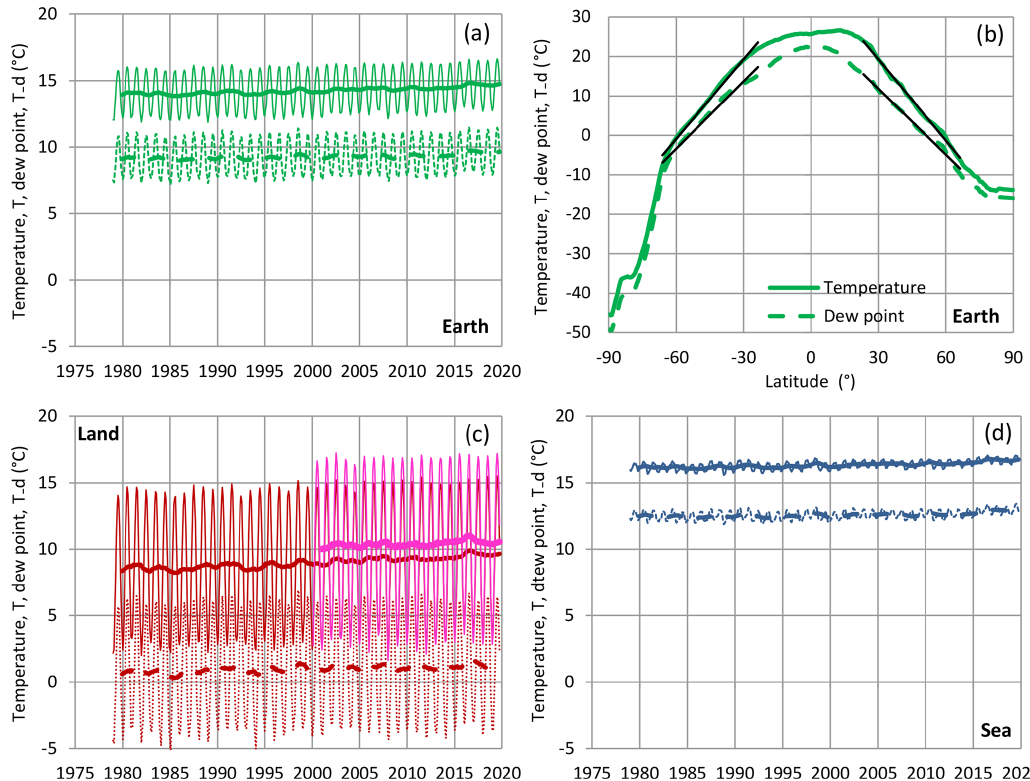
Figure 2. (a) Variation of the globally averaged temperature (continuous lines) and dew point (dashed lines) at the level of 2m above ground. Thin and thick lines of the same colour represent the monthly values and running annual averages (right aligned), respectively. (b) Zonal distribution of Earth temperature and dew point; for the temperate zone ( ± 23 . 5 to ± 66 . 5 ◦ ), the fitted slopes are also plotted (in black), which are ± 0 . 68 ◦ C per degree and ± 0 . 56 ◦ C per degree, respectively. (c, d) The same as in panel (a) but for the land and sea parts. Source of the data set is the ERA5 reanalysis, as detailed in Table 1; for comparison and validation, in the land graph the MODIS-Terra land surface temperature (averages of daytime and nighttime data sets available since 2000) is also plotted in